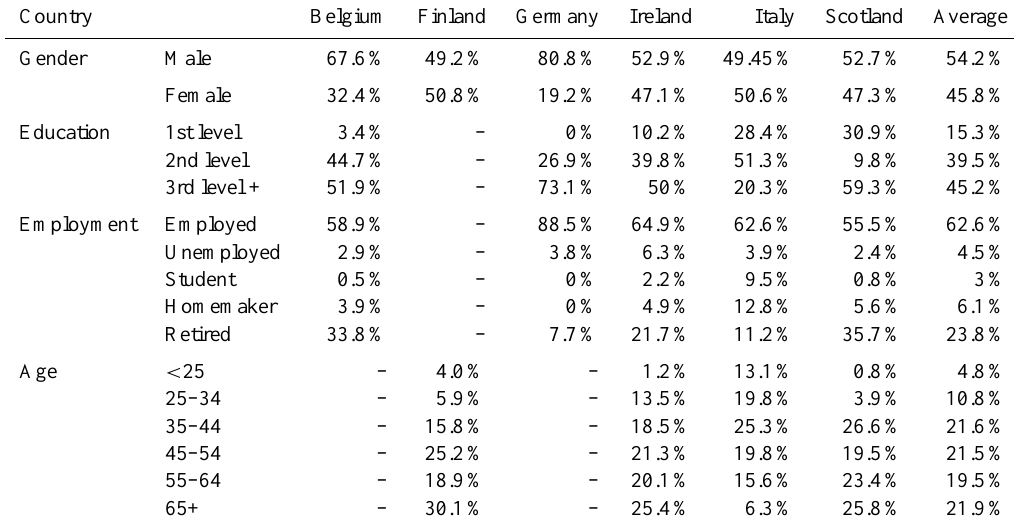
Table 4. Gender, attained education levels, employment status and age of respondents.